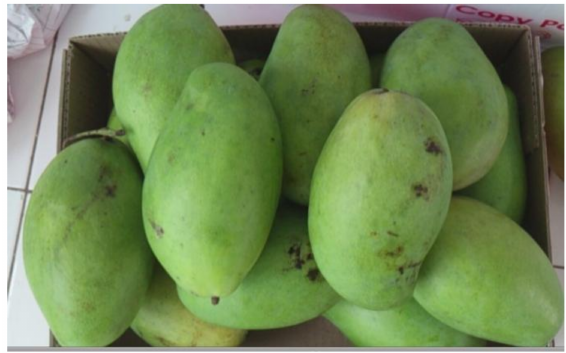
Figure 1. “Elephant”